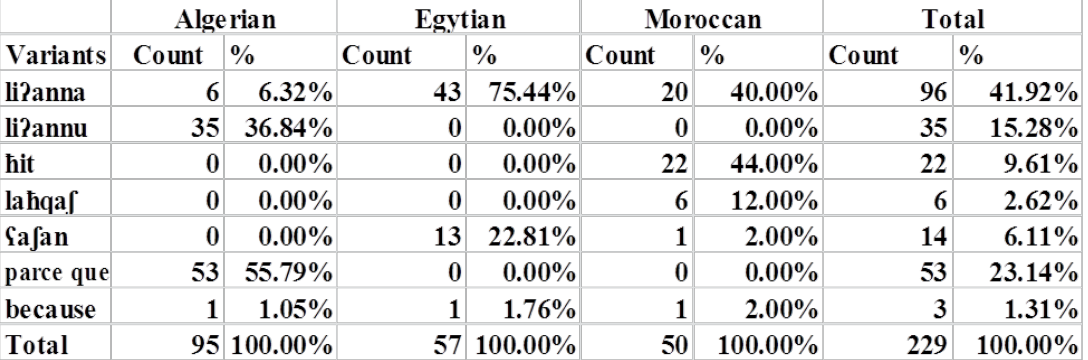
Table 2. The results of causality broken down by nationality